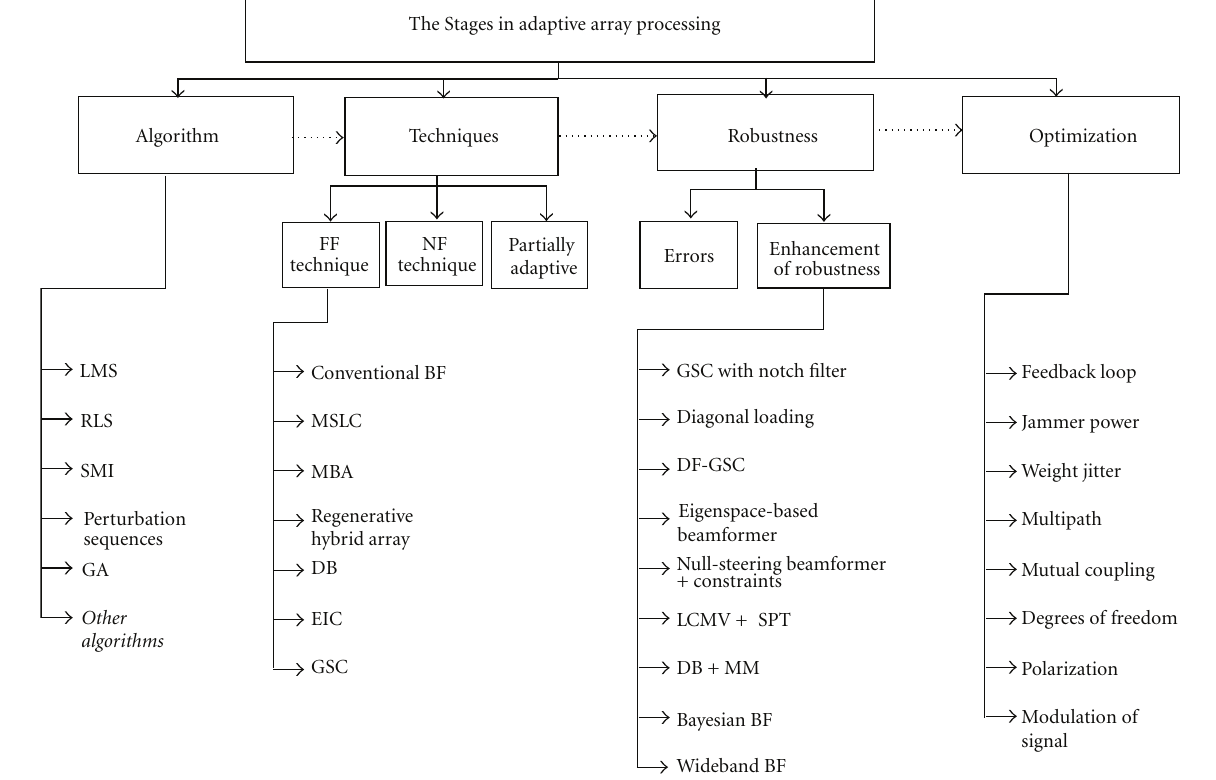
Figure 1: Schematic chart for adaptive array